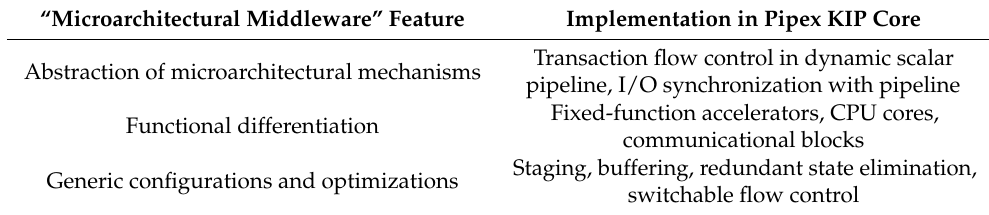
Table 1. Summary of “microarchitectural middleware” features of Pipex KIP core.